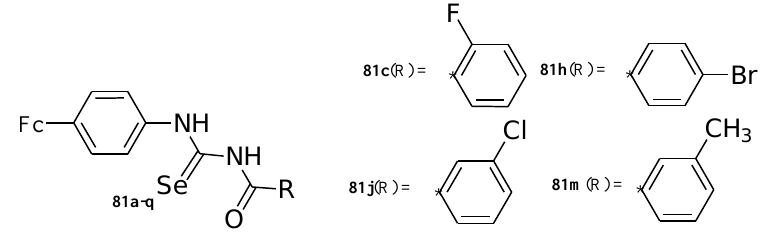
Figure 28. Chemical structures of ferrocene incorporated selenourea derivatives ( 81a – q ).